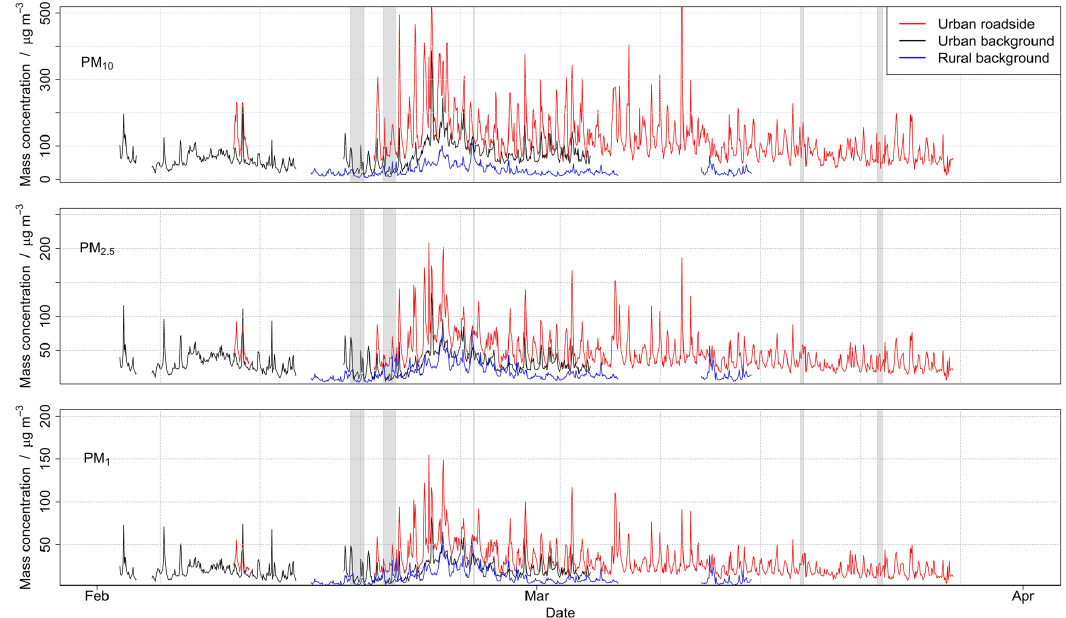
Figure 2. Hourly time series data showing PM 10 , PM 2 . 5 and PM 1 mass concentrations at the three study locations. Red line is the urban roadside, black line is the urban background and blue line is the rural background. Where multiple OPC-N2 devices were measuring in the same location at the same time, the average is provided. The grey shading represents rain events as measured at the urban background